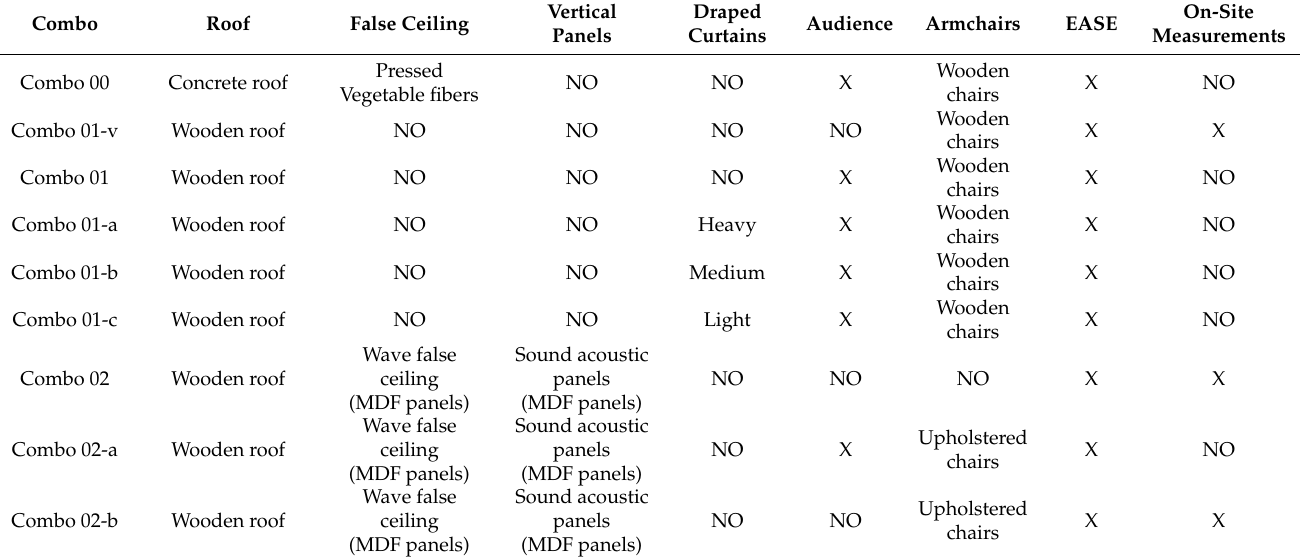
Table 6. List of different configurations.